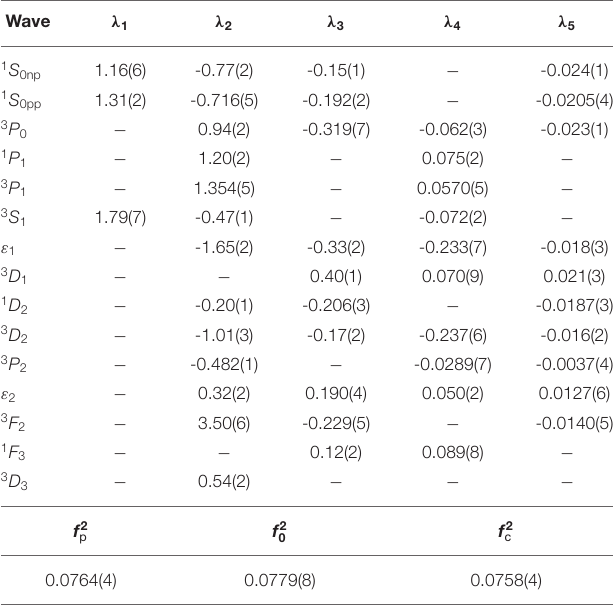
TABLE 5 | Fitting delta-shell parameters ( λ n ) JS l , l (in fm − 1 ) with their errors for all ′ states in the JS channel for a fit with isospin symmetry breaking on the 1 S 0 partial wave parameters only and the pion-nucleon coupling constants f 2 0 , f 2 p , and f 2 c as fitting parameters We take N 5 equidistant points with 1 r 0.6 = =